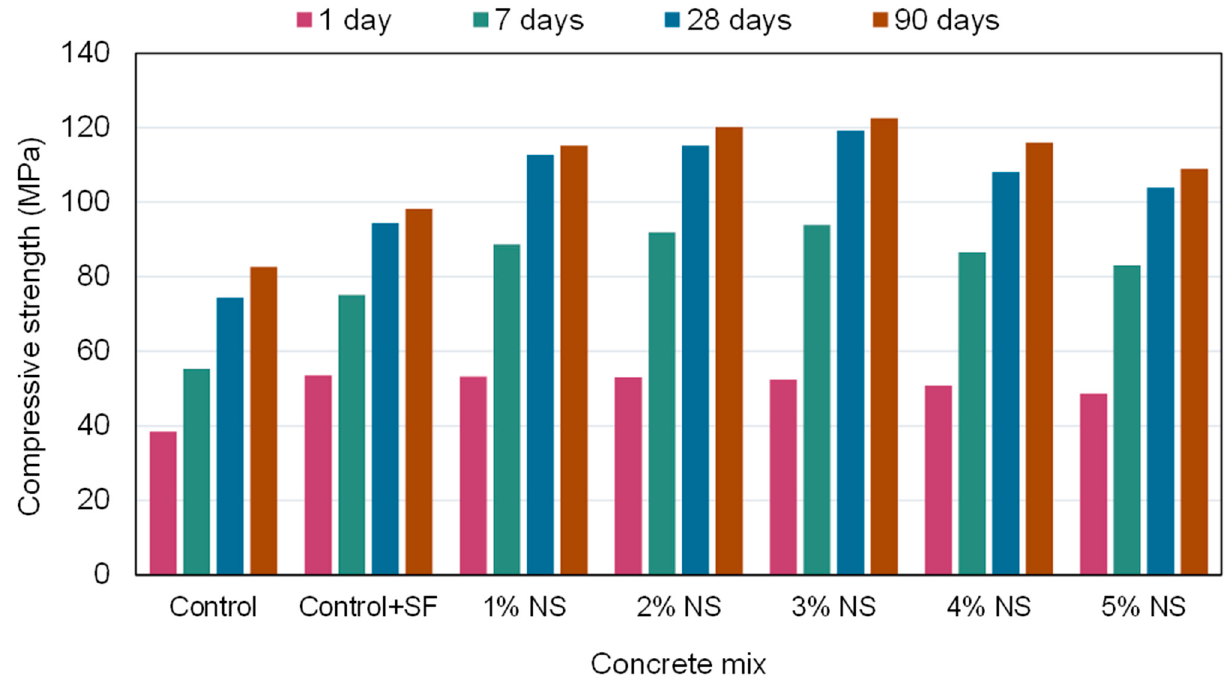
Figure 6. Influence of nano-silica dosage on compressive strength at different curing ages [131].